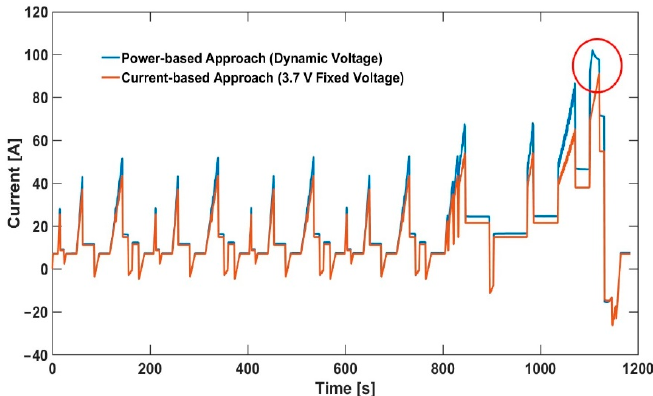
Figure 4. Comparison between current profiles for power-based approach and current-based approach for NEDC at − 15 °C ambient temperature and 65% starting SOC.